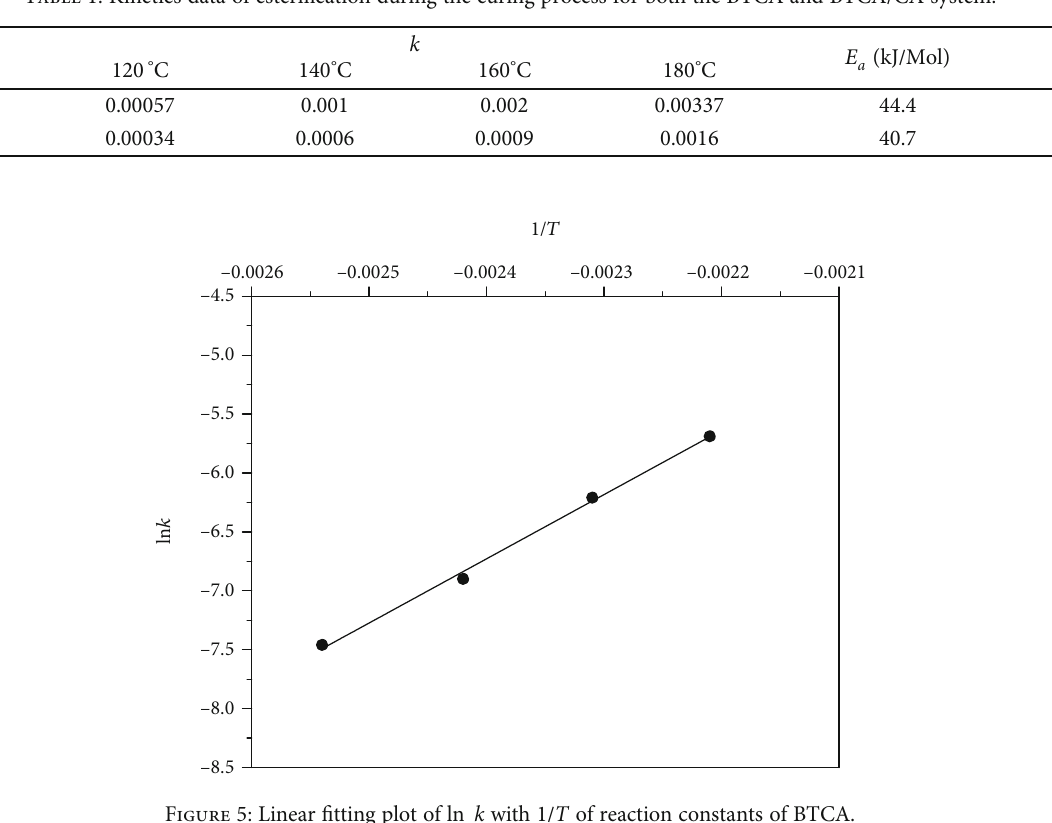
Figure 5: Linear fi tting plot of ln k with 1/ T of reaction constants of BTCA.